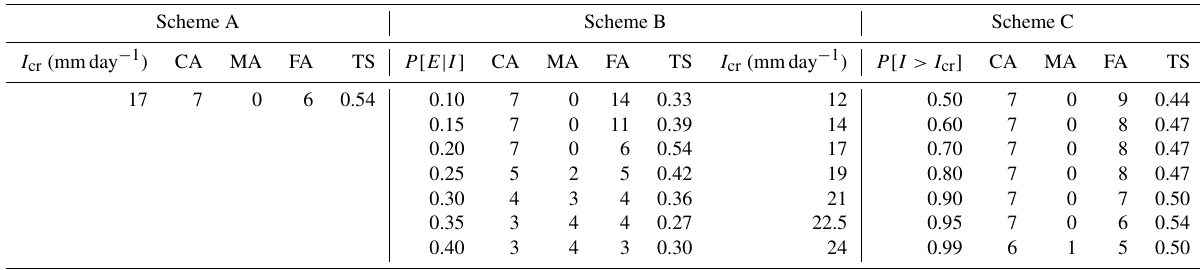
Table 2. Gimigliano municipality (southern Italy): validation results (period 2007–2011) for Schemes A, B and C. Scheme A Scheme B Scheme